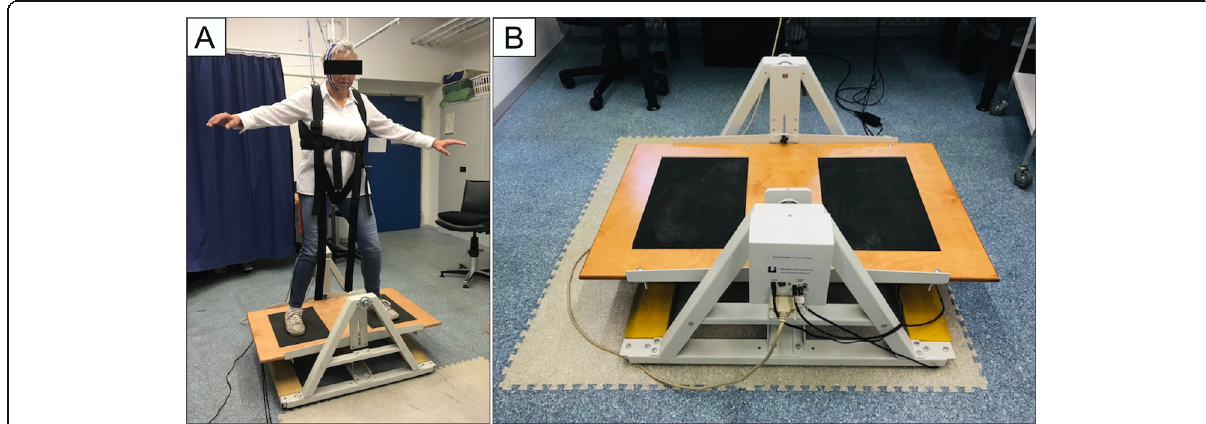
Fig. 1 Experimental set-up. a Middle-aged woman (57 years old) performing the complex whole body dynamic balance task. Informed written consent has been given for publishing the picture. b Lafayette Instrument 1600 stability